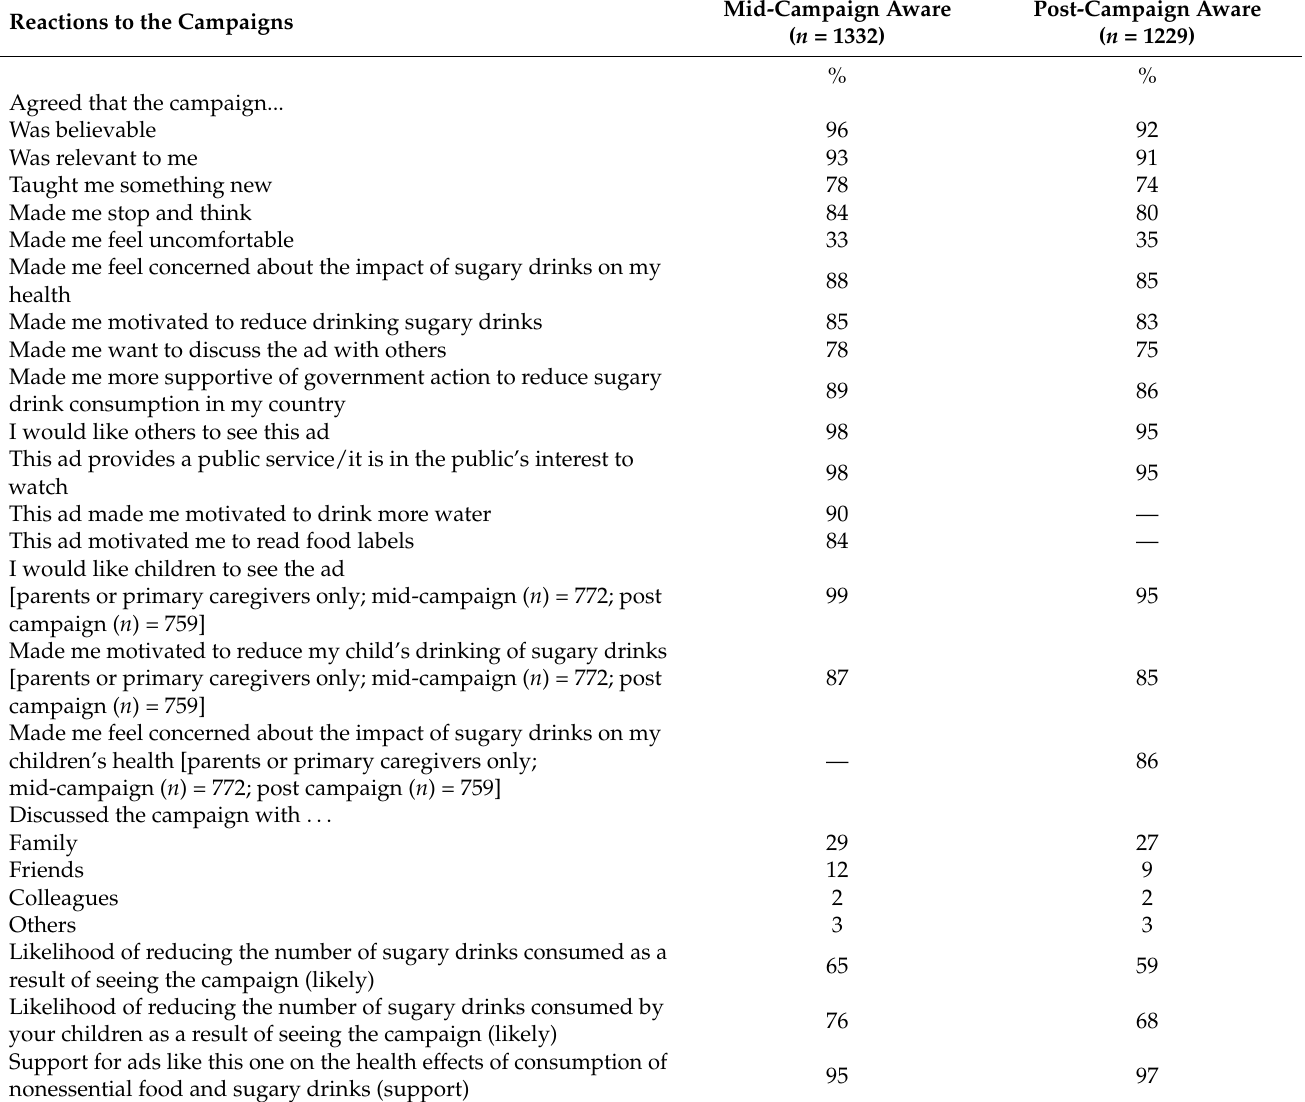
Table 4. Reactions to the campaign materials among those who recalled it through any